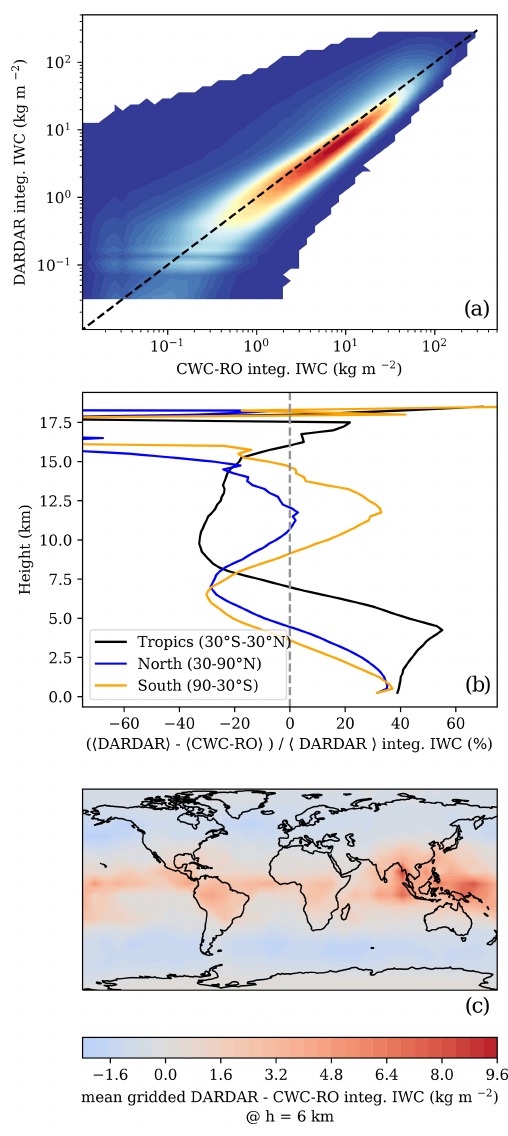
Figure A1. Comparison between the integrated IWC from the CloudSat retrieval using the 2B-CWC-RO and DARDAR V3. Panel (a) shows the relationship between integrated IWC from the 2B- CWC-RO ( x axis) and DARDAR V3 ( y axis) for all observations, regardless of height. Panel (b) shows the fractional difference be- tween the mean DARDAR V3 and 2B-CWC-RO-integrated IWC as a function of height, for three different latitudinal bands (see the legend). Panel (c) shows the gridded mean DARDAR–2B-CWC- RO-integrated IWC corresponding to a tangent height of 6km.